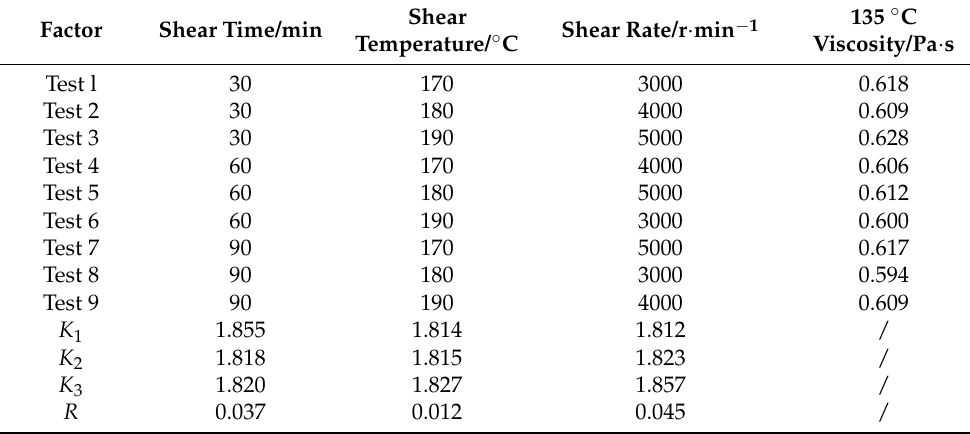
Table 8. Calculation results of viscosity test R and K values of PE modified asphalt.